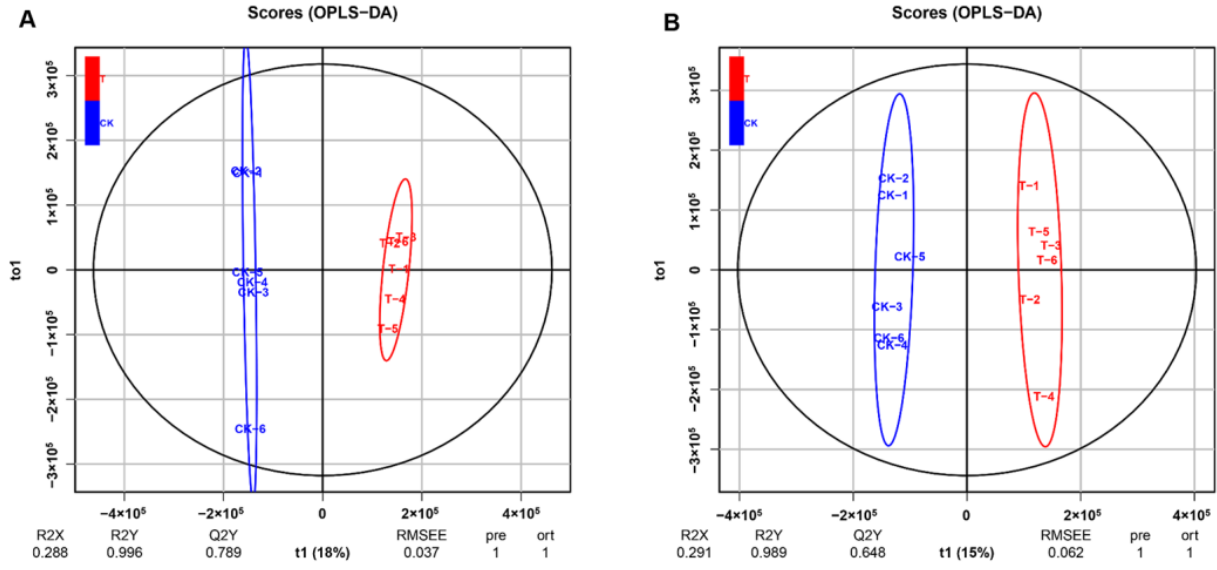
Figure 4. Expression of eight differentially expressed genes from the transcriptome validated by qRT-PCR.